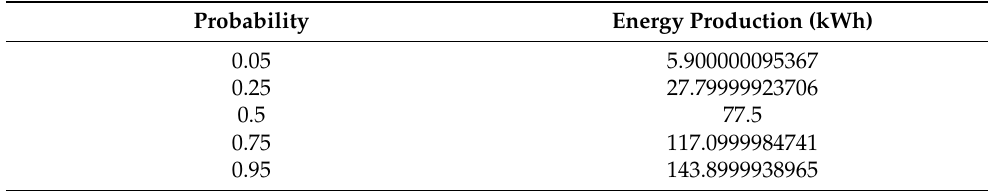
Figure 9. Monthly electricity production by the WSEI mini carport in 2022. Basic statistical calculations show that in 2022 the minimum value of energy produced per month was 5.9 kWh, the maximum value was 143.9 kWh, and the average value of energy produced was 67.475 with a standard deviation of 49.558. The Metalog family of distributions also allows for more advanced statistical analysis in this case, including the determination of quantiles, as shown in Table 2. Table 2. Quantile parameters.